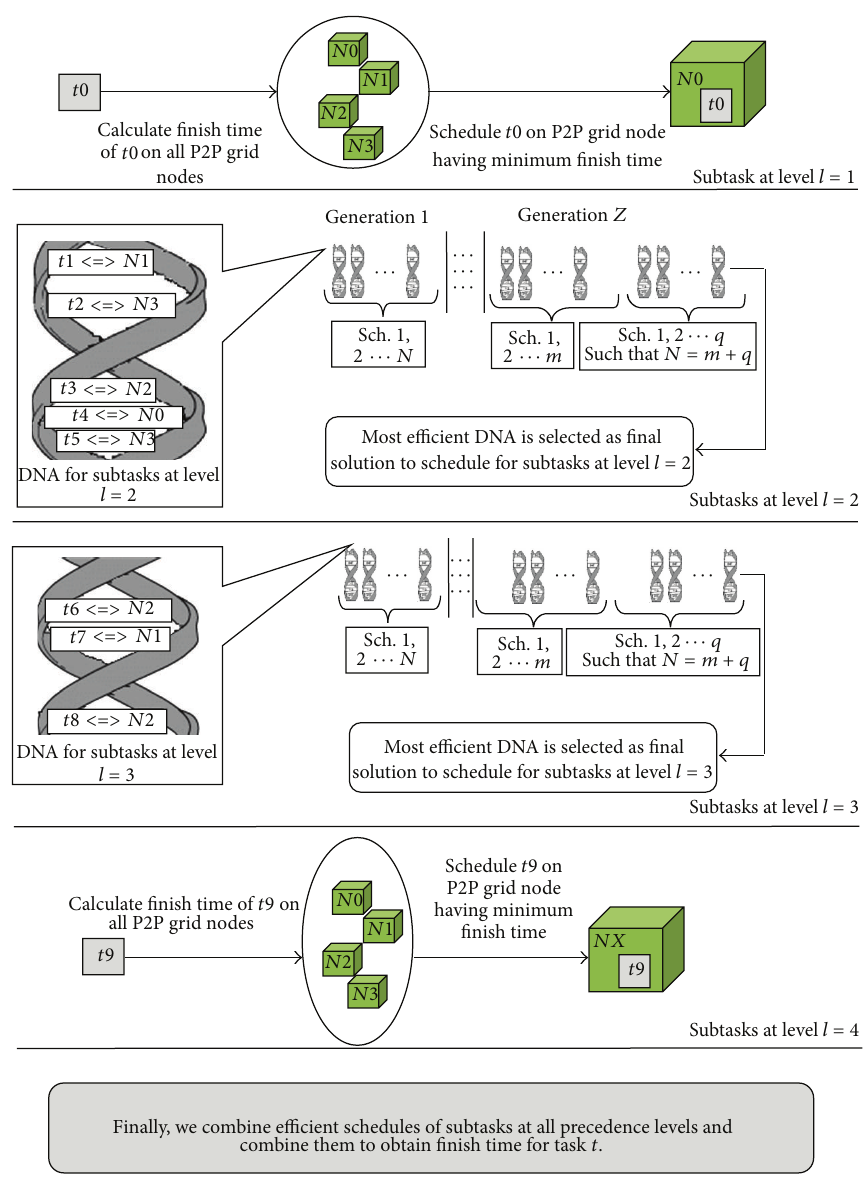
Figure 4: Diagrammatic presentation of